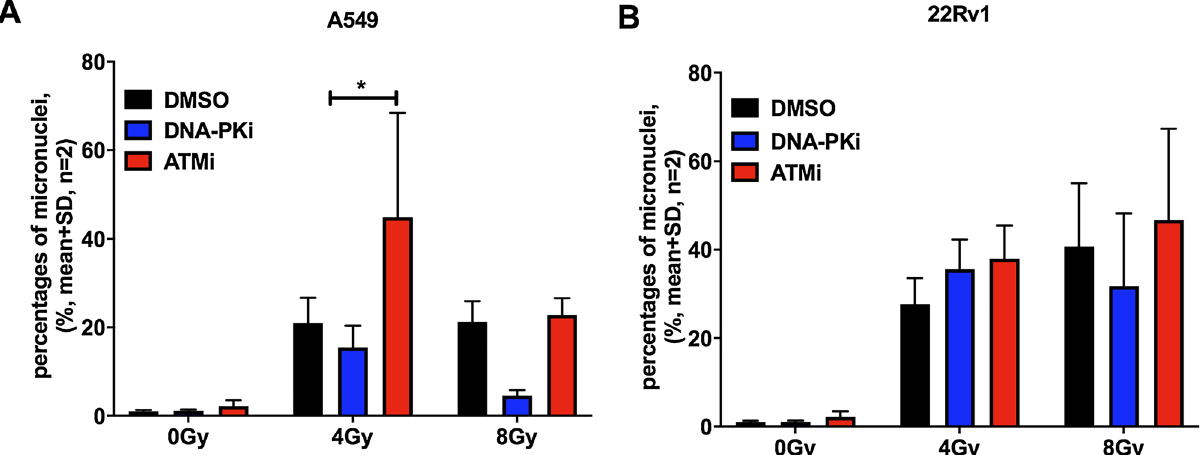
Figure 4. ATM inhibitor increased the formation of micronuclei after X-ray radiation in A549 ( A ) and in 22Rv1 ( B ). A549 and 22Rv1 cancer cell lines were treated with 200 nM DNA-PKi or ATMi for 2 h prior to X-ray exposure of 4 and 8 Gy, then were incubated an additional 24 h (48 h for 22Rv1) before analysis; statistical analysis: 2way ANOVA, Dunnett’s multiple comparisons test: mean + SD, n = 2, (*) p <